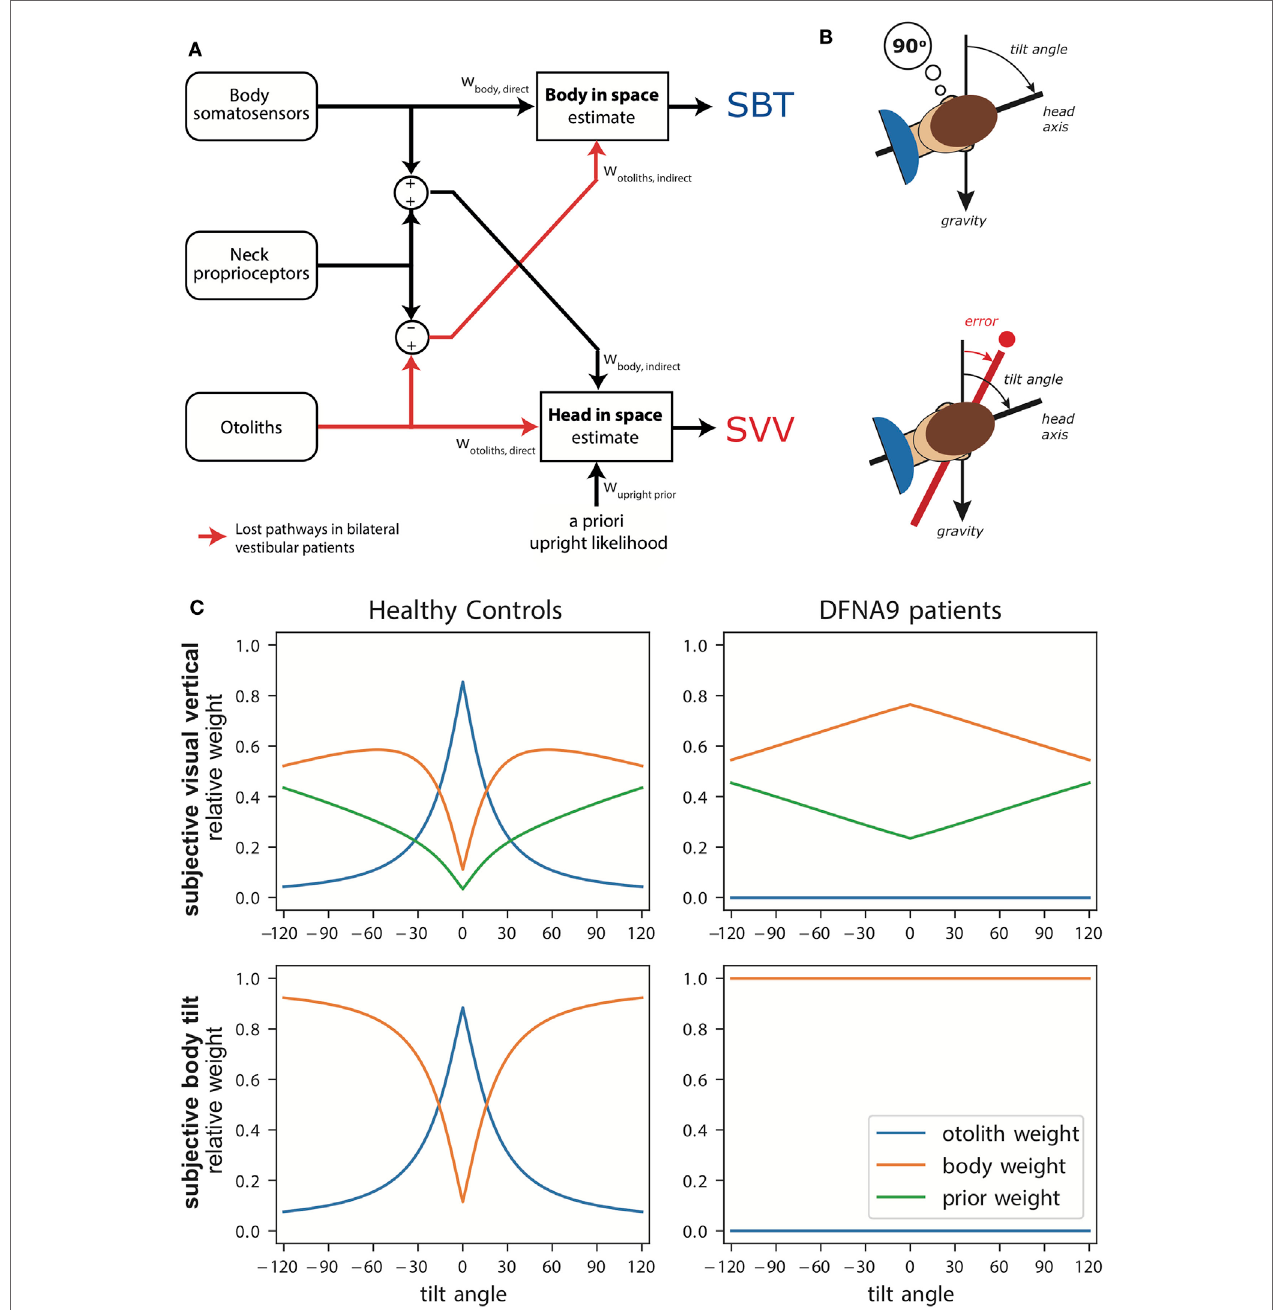
FigURe 1 | (A) Schematic of the Bayesian optimal integration model by Clemens et al. (5). In the subjective body tilt (SBT) task, body somatosensors provide direct information about body orientation in space, whereas the otolith signals undergo a coordinate transformation based on neck proprioception and provide an indirect measurement of body orientation in space. Both signals are weighted (w body, direct , w otoliths, indirect ) based on their reliability to provide an estimate of body orientation in space. Weights are always relative, summing to unity. In the subjective visual vertical (SVV) task, the otoliths provide direct information about the head-in-space and the body somatosensors provide indirect information. In addition, the brain assumes that upright head orientations are more likely based on prior experience. All three signals are weighted (w otoliths, direct , w body, indirect , w upright, prior ) in proportion to their reliability to provide a head-in-space estimate. (B) Schematic of the SBT and SVV task. In the SBT task, the subject is given a reference orientation (here 90°) and subsequently rotated in roll, in complete darkness, to an orientation around this reference. Subsequently, the subject is asked to indicate whether his/her current orientation is clockwise or counterclockwise relative to the given reference. In the SVV task, the subject is rotated to a roll tilt angle in complete darkness. Subsequently, a line if briefly flashed and the subject must indicate whether this line is oriented clockwise or counterclockwise relative to gravity. (C) Weights attributed to the signals in the Bayesian optimal integration model for healthy controls and bilateral vestibular patients for the SVV and SBT task. Note the clear difference in weighting between patients and control. Weights are derived based on sensory noise levels determined in Alberts et al. (20, 22).